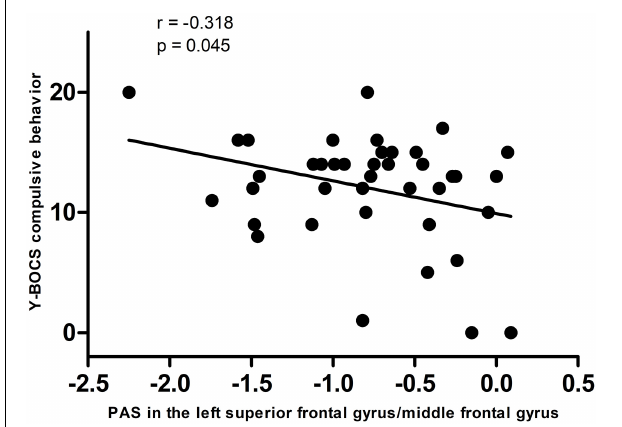
FIGURE 2 | A negative correlation between PAS scores in the left dorsolateral prefrontal cortex and Y-BOCS compulsive behavior scores in the patients. PAS, parameter of asymmetry; Y-BOCS, Yale–Brown Obsessive-Compulsive Scale.